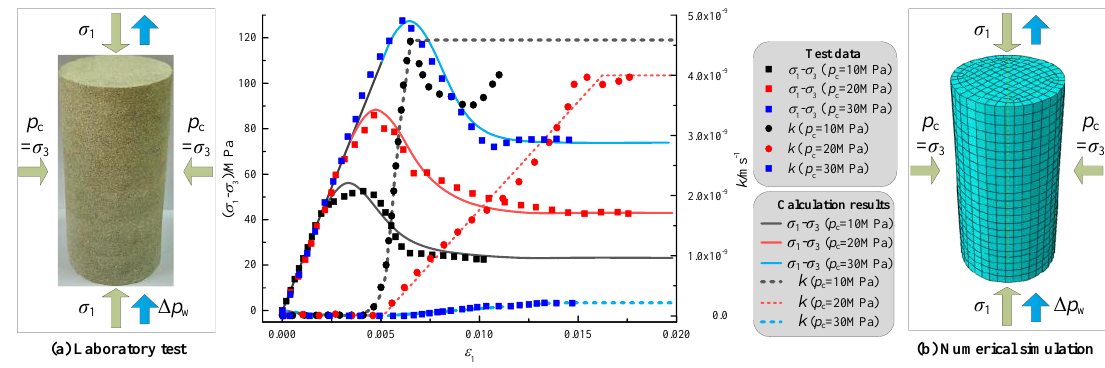
Figure 9. Comparison of experimental and calculated results under different confining pressures.